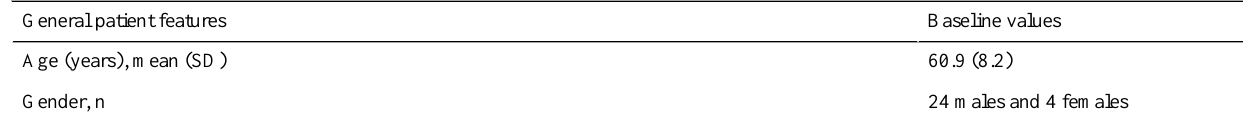
Table 1. Presentation of baseline patient features, cardiac pathology, and medication information (n=28).